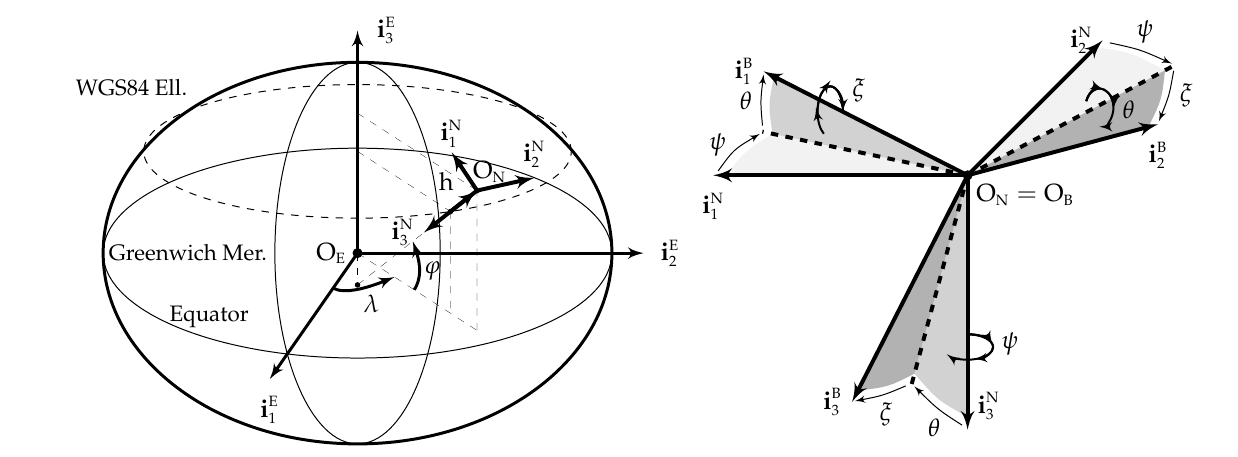
), NED (F E ), NED (F E